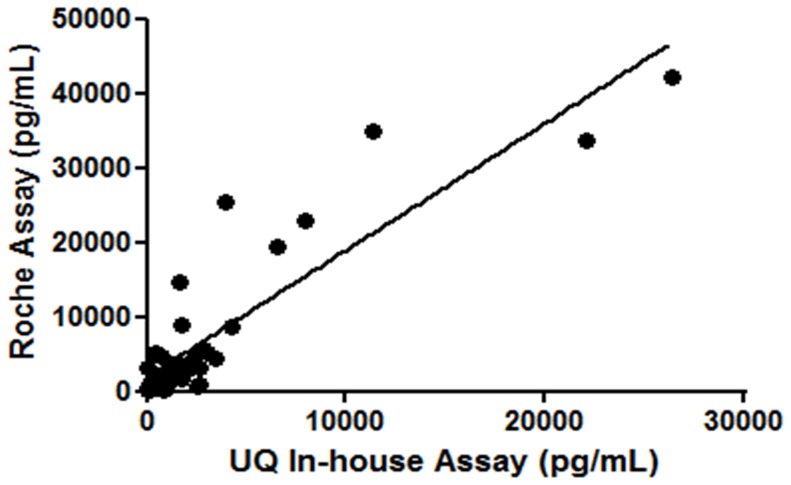
Comparison of the NT-proBNP immunoassay when compared with a commercially available diagnostic assay (Roche Diagnostics, USA).r2 = 0.78 and p<0.001.